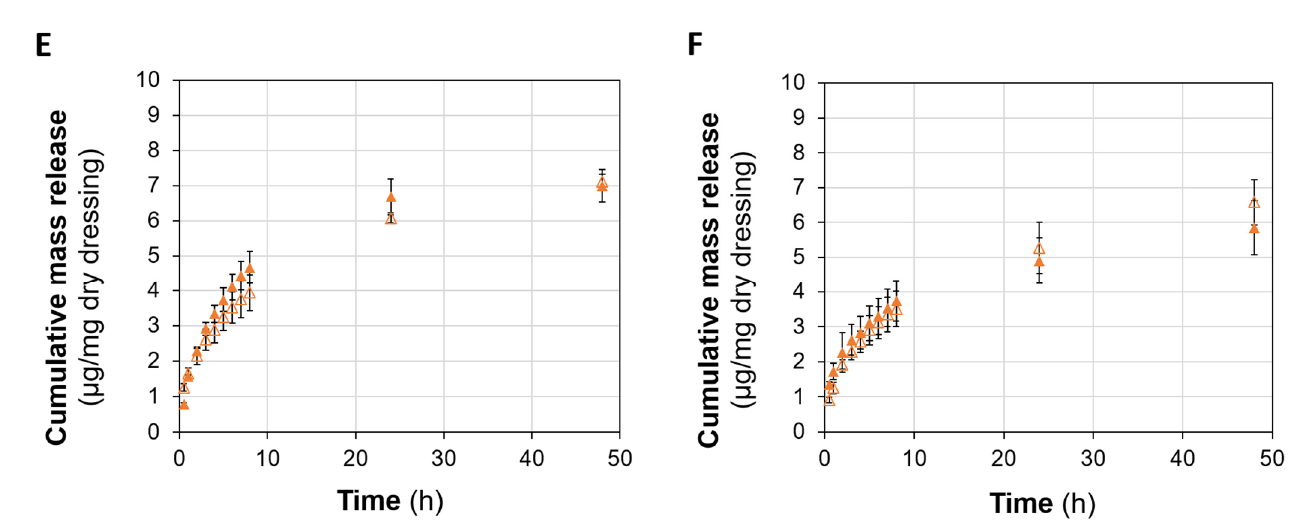
Figure 6. Cumulative drug release profiles from sterile (solid symbols) and non-sterile (open symbols) CS ( A , C , E ) and C ( B , D , F ) hydrogels: 2-Phenoxyethanol ( A , B ), octenidine dihydrochloride ( C , D ), and polyhexanide ( E , F ). Error bars correspond to ± standard deviations (n = 3).